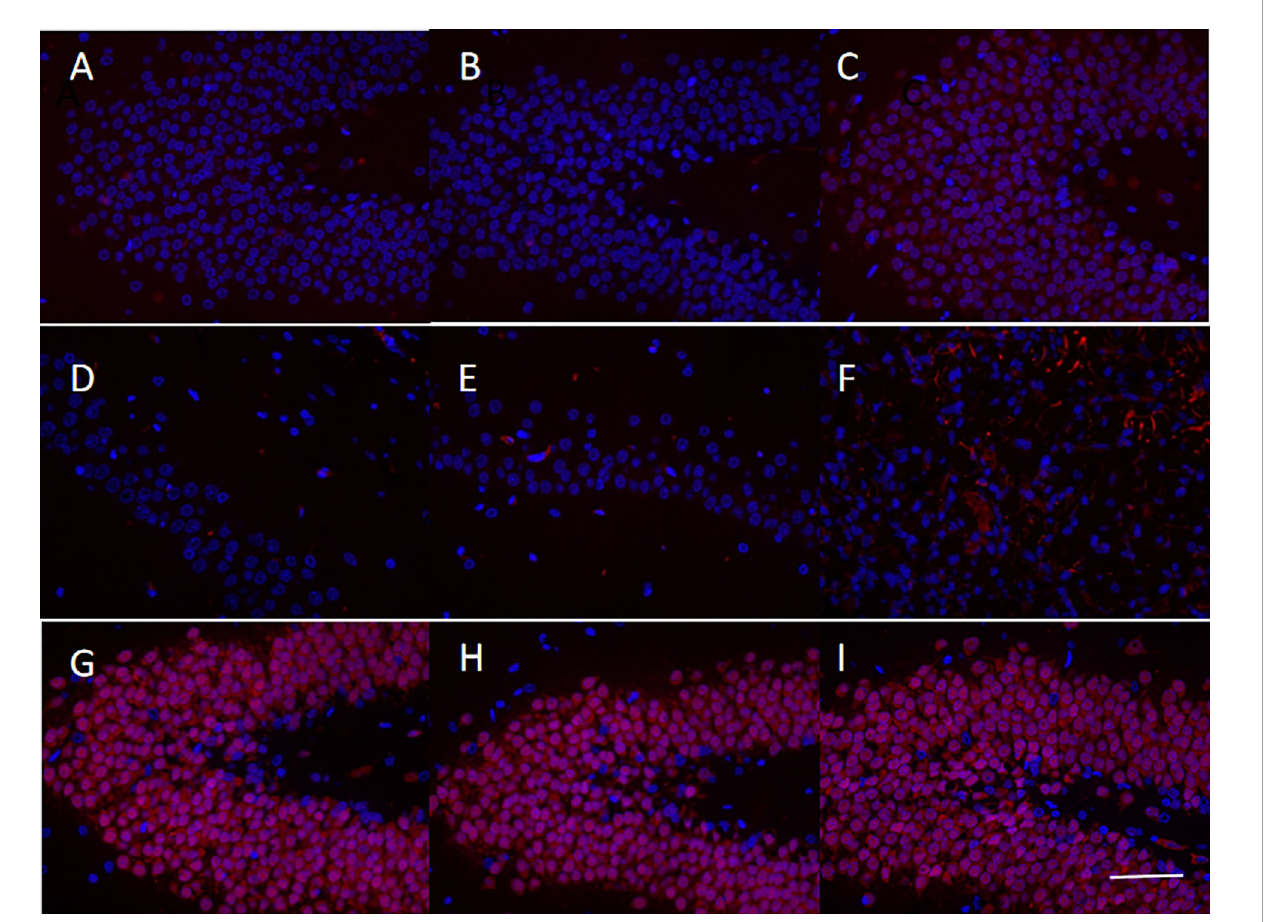
FIGURE 6 Levels of chemokines and neuronal markers in the brain tissues of MCAO rats after administration of hUCMSCs. The fi gures show the immuno fl uorescence staining results of CXCR4 (A – C) , Nestin (D – F) , and NeuN (G-I) in the normal group, model group, and treatment group, respectively. The staining magni fi cation is 400 times and the scale is set at 2.5